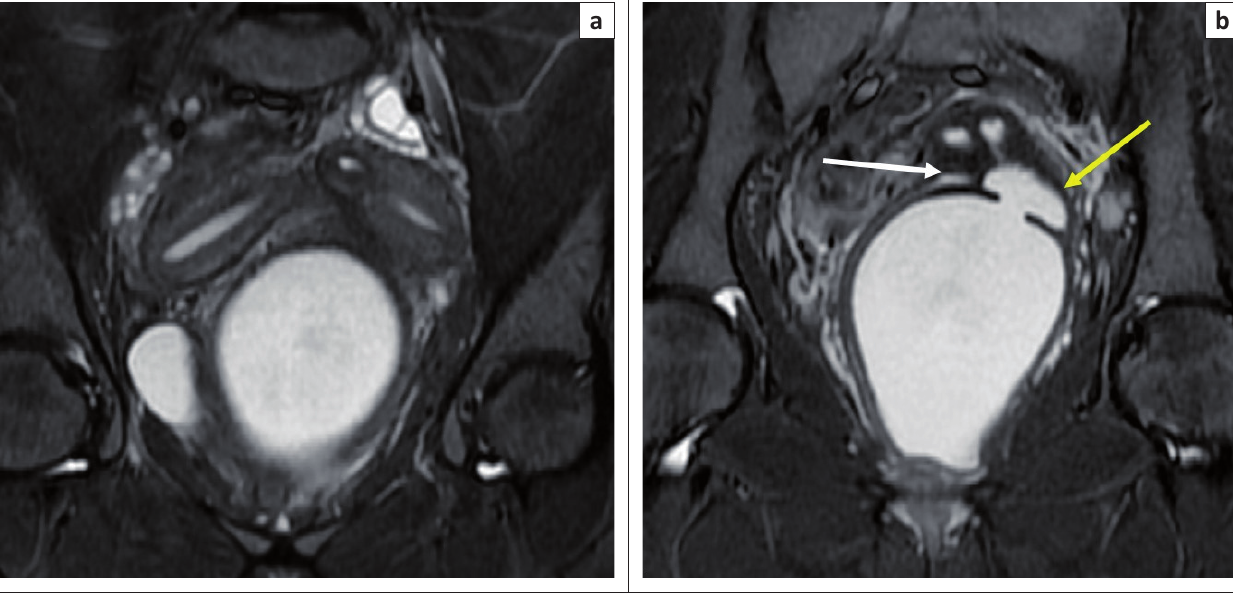
FIGURE 13: Coronal short tau inversion recovery (STIR ) sequence (a) demonstrates two uterine bodies with endometrial cavities. Coronal STIR sequence (b) shows two cervices with a compressed right hemivagina (white arrow) and an obstructed fluid distended left hemi-vagina (yellow arrow). It also shows a transverse partial septum. Associated ipsilateral renal agenesis was seen (not shown). Herlyn–Werner–Wunderlich